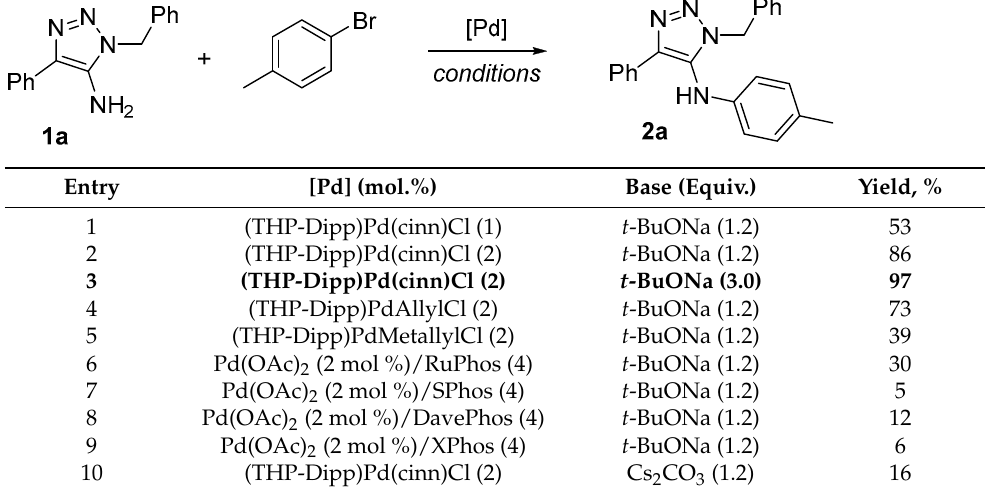
Table 1. Screening of catalytic systems in the BHA reaction 1 .